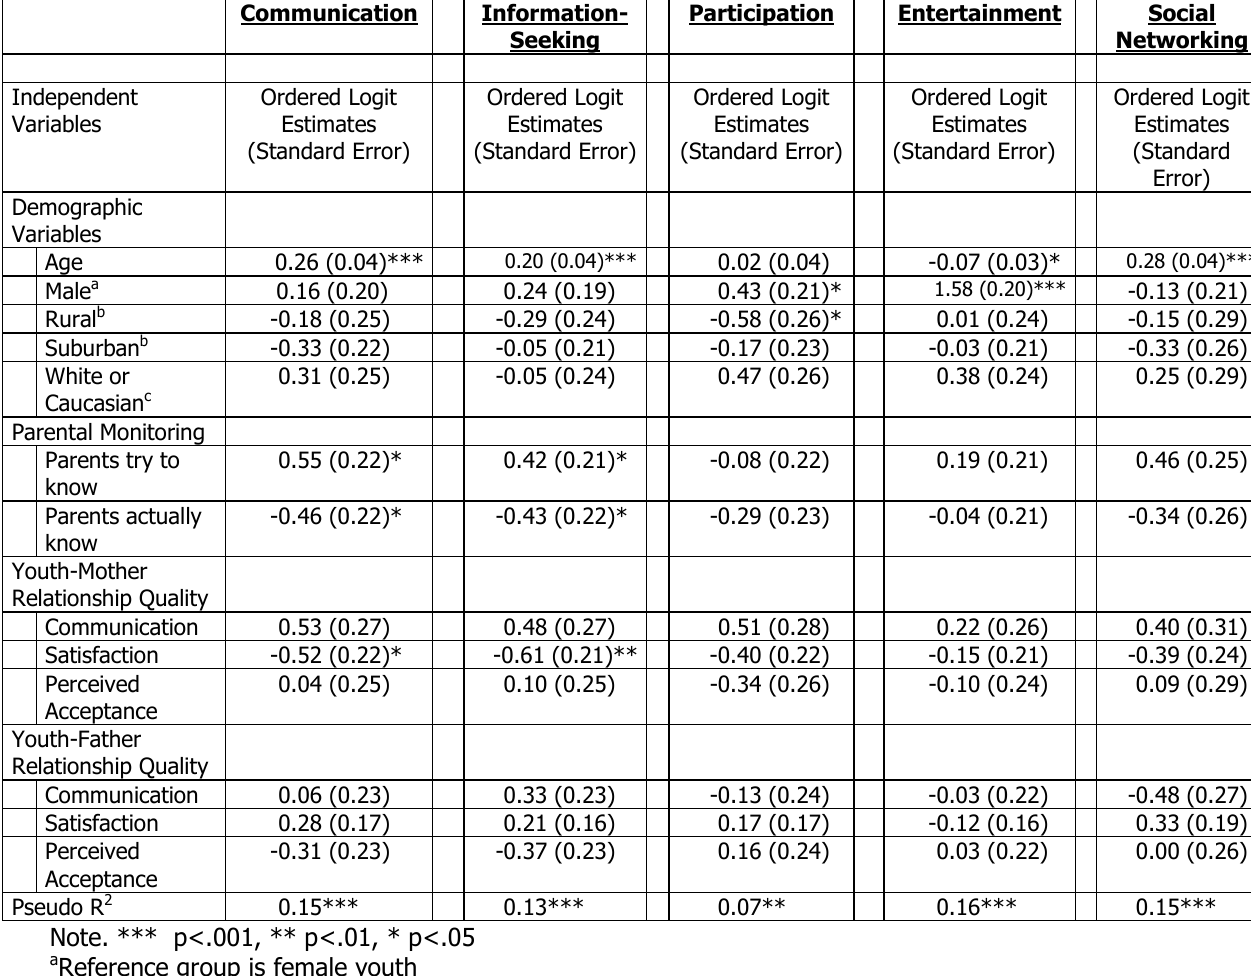
Associations between youth demographics, parental monitoring, parent-youth relationship quality, and user group (high, medium, or low) for each online media activity Communication Information- Participation Entertainment Seeking